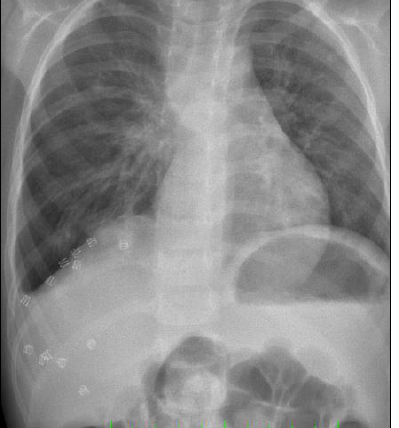
Figure 3: Chest X-ray. Three-year follow-up